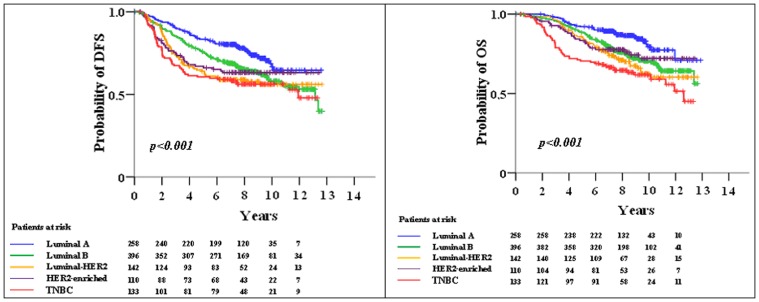
DFS and OS according to breast cancer subtypes.Patients were classified as: luminal A (ER-positive and/or PgR-positive, HER2-negative, Ki67low); luminal B (ER-positive and/or PgR-positive, HER2-negative, Ki67high); luminal-HER2 (ER-positive and/or PgR-positive, HER2-positive); HER2-enriched (ER-negative, PgR-negative, HER2-positive); and triple-negative (TNBC) (ER-negative, PgR-negative, HER2-negative).